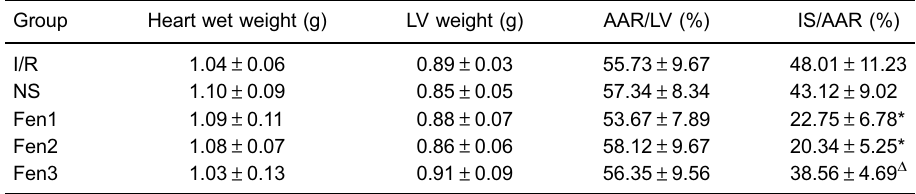
Table 2. Comparison of myocardial infarction area in each group (n=20).